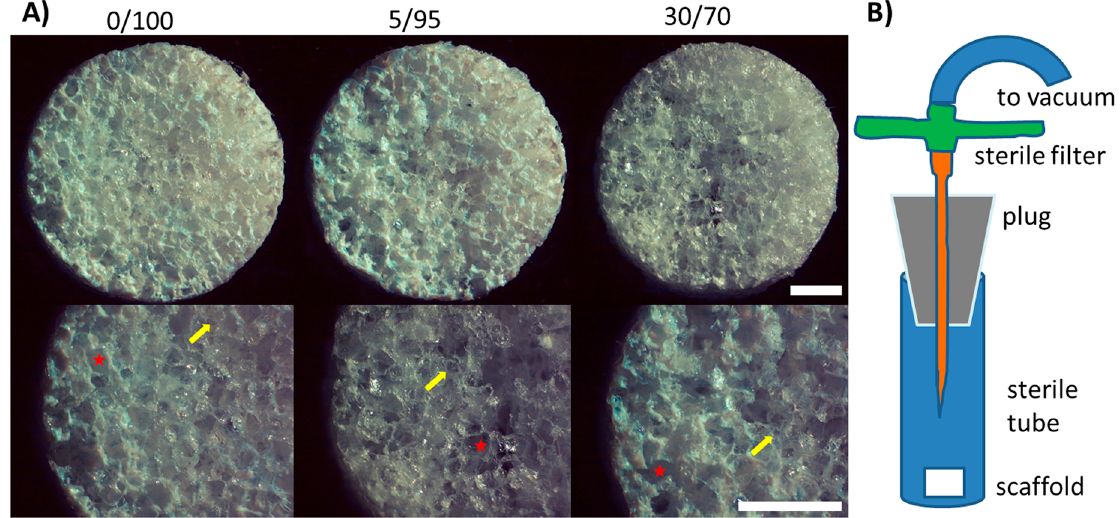
Figure 1. ( A ) Macroscopic imaging of scaffolds of different composition before seeding; primary and secondary pores show equal sizes. Stars indicate primary pores (250–300 µm in diameter), arrows point towards smaller secondary pores (50–100 µm); (scale bars = 1 mm); ( B ) Schematic of seeding of the scaffolds under vacuum conditions with hMSCs. The cell suspension is injected through the sterile filter before application of the vacuum.